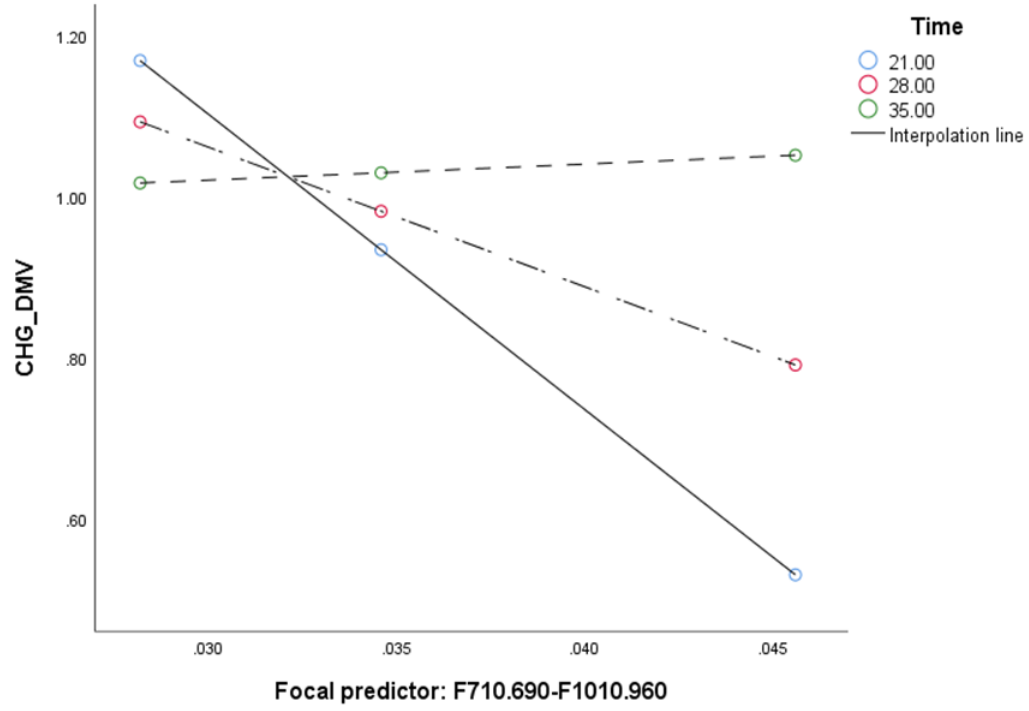
Figure 4. Conditional effect of the integrated absorbance area for regions 710–690 and 1010–940 cm −1 (F710.690-F1010.940; predictor) under different durations of in vitro anther culture.